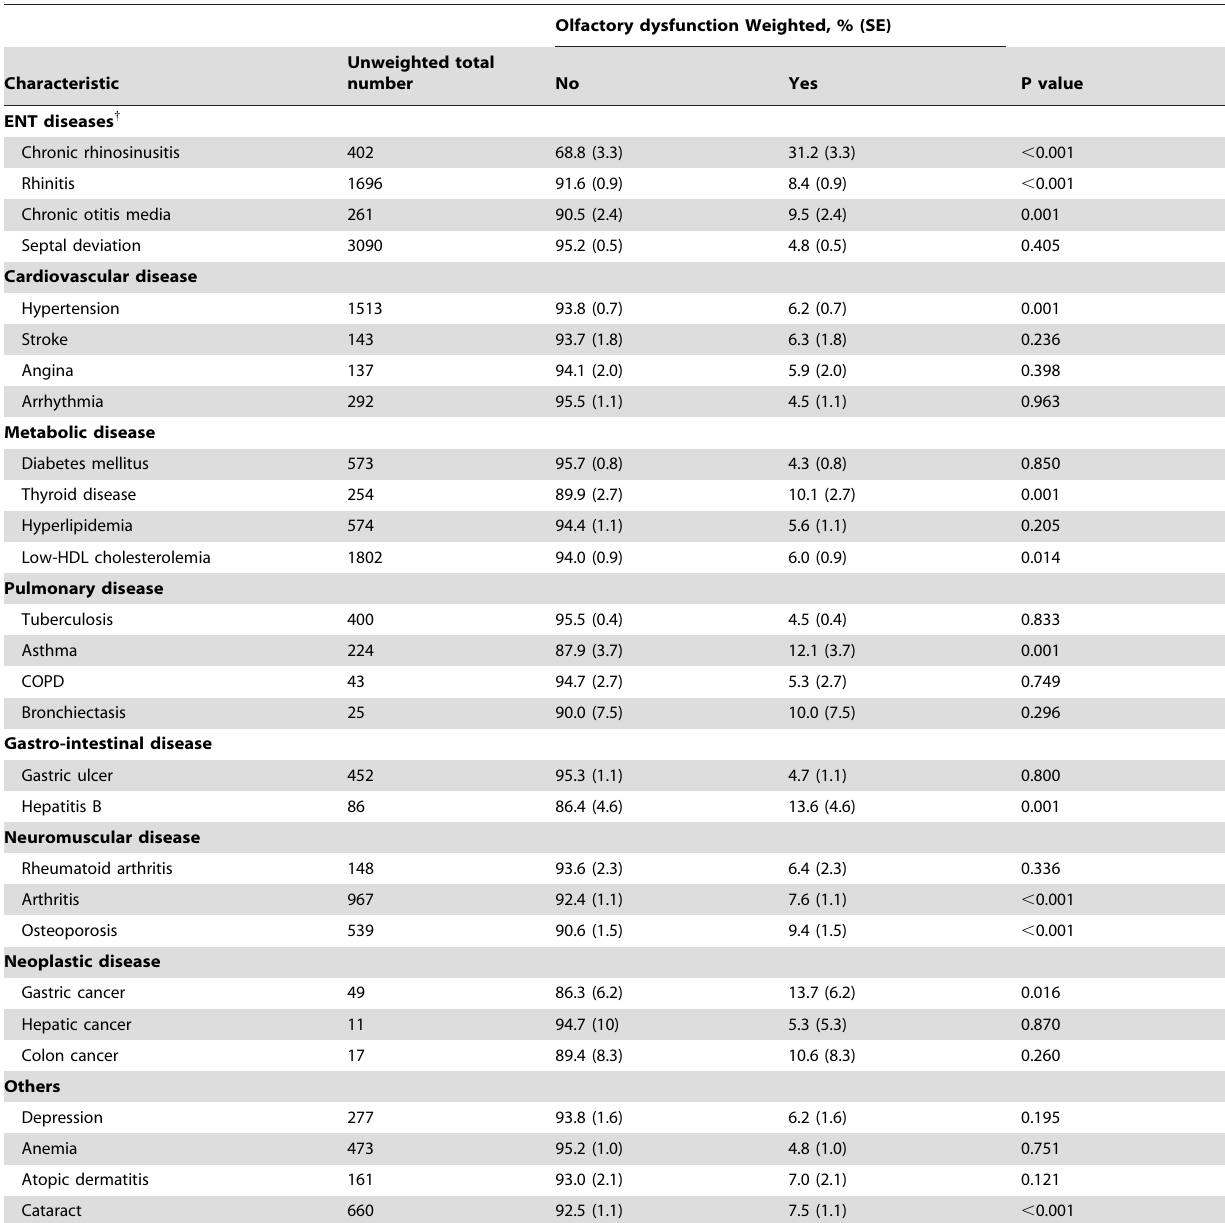
Olfactory dysfunction Weighted, %